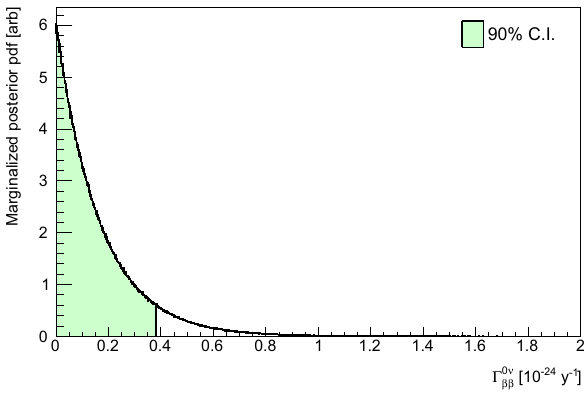
Fig. 16 The posterior distribution of the decay rate for 0 νββ decay run with all nuisance parameters floating. The shaded area under the curve represents the 90% CI with upper limit at a value of (cid:4) 0 ν = 3 . 8 × 10 − 25 y − 1